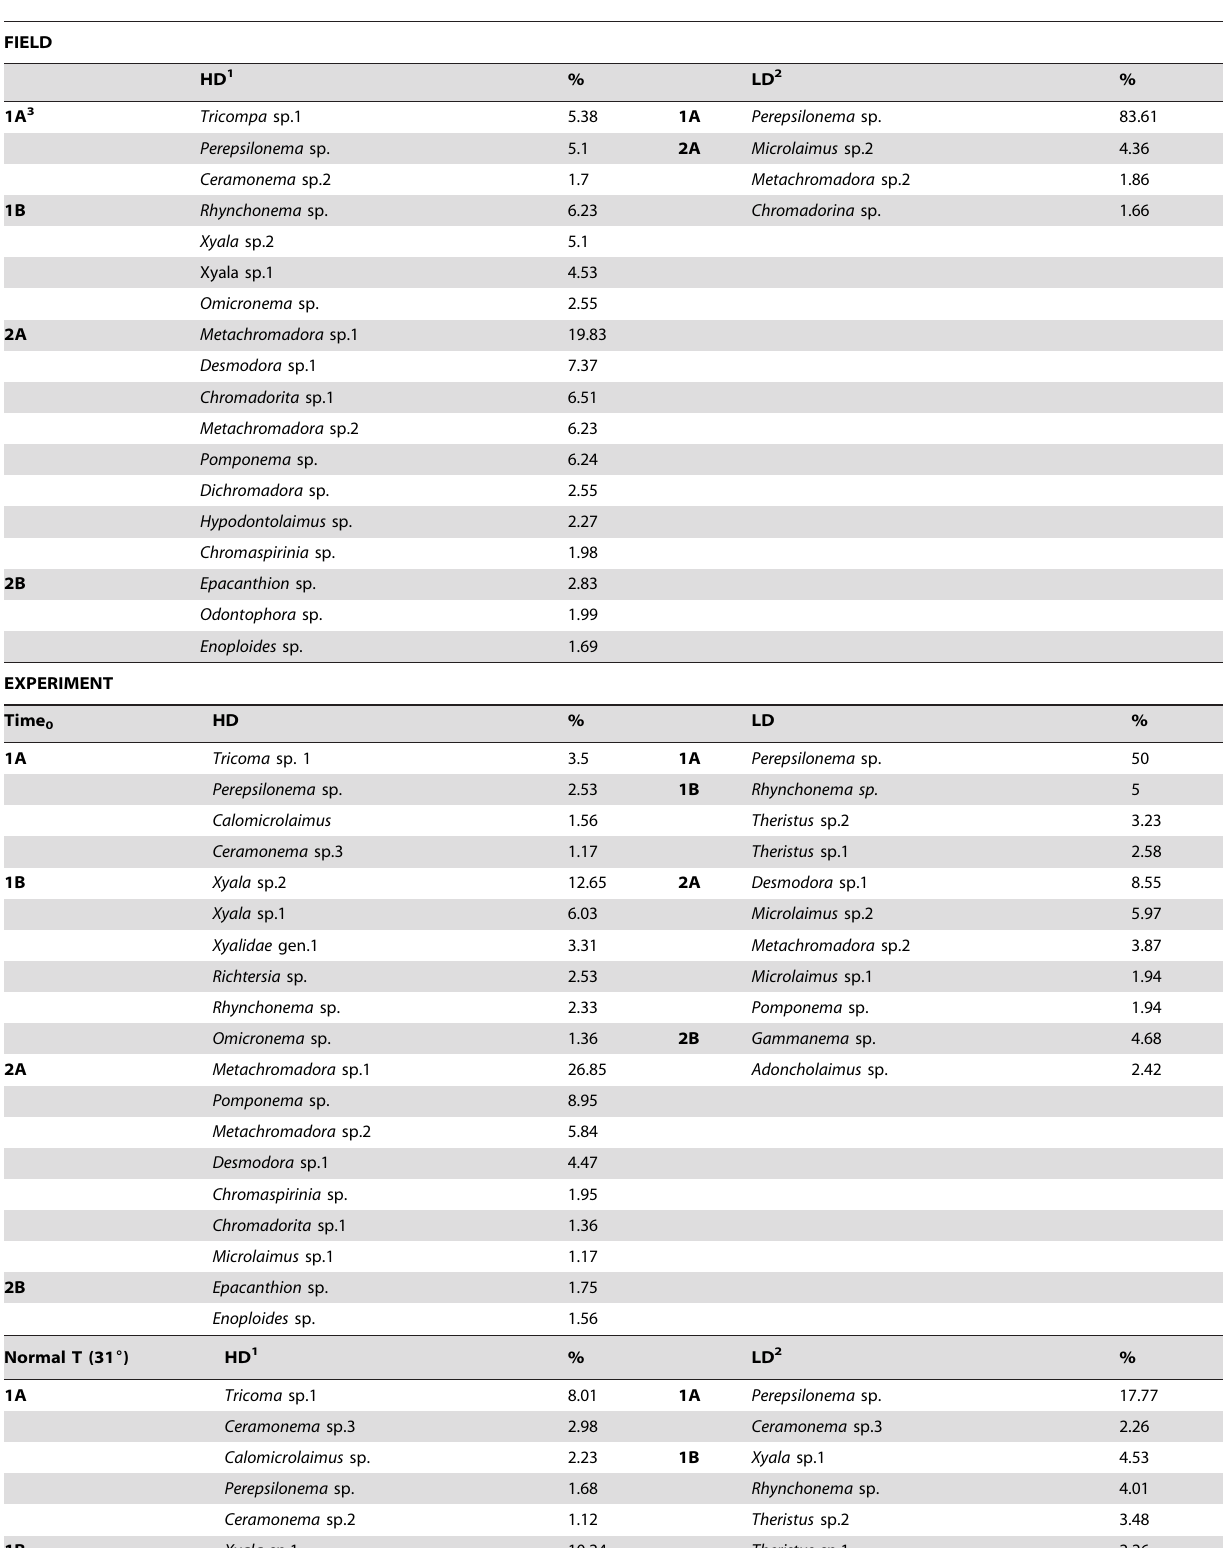
Table 3. Percentages contribution (%) of the top 90% discriminating genera of the two field stations and the six experimental groups.